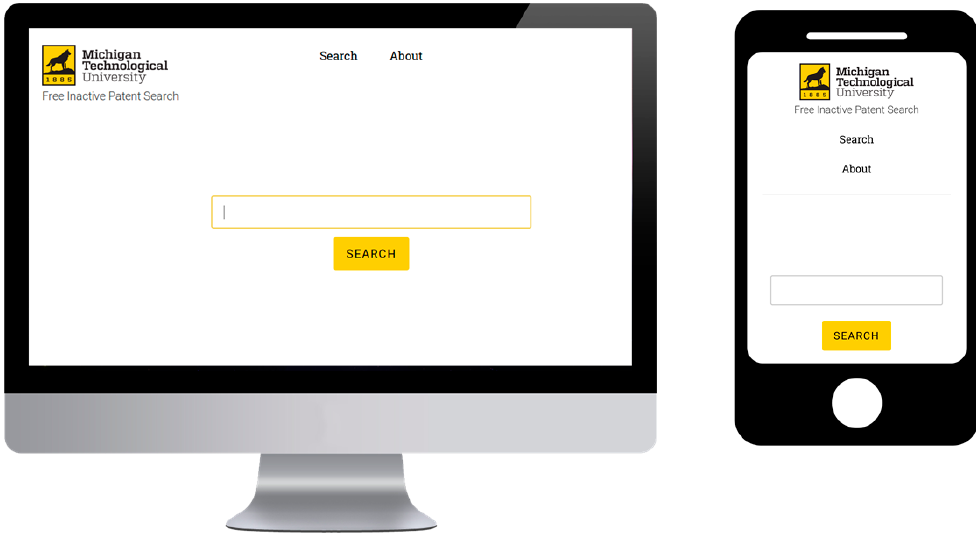
Figure 1. The Free Inactive Patent Search Page displayed on a PC and mobile device.